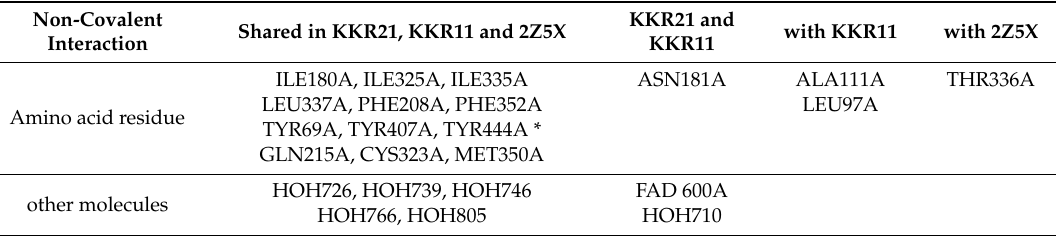
Table 3. Predicted responsible reversible interactions between MAO-A active site residues and KKR21 and KKR11; involved amino acid residues, cofactor, and water molecules in KKR21, KKR11, and the standard ligand harmine (2Z5X). The hydrophobic interactions are compared to 2Z5X, which was re-docked within the same